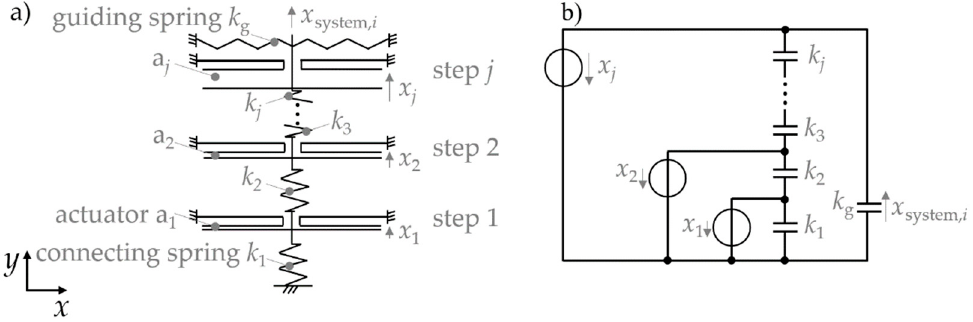
Figure 2. ( a ) Setup of the system, ( b ) analogous electrical network model, (drawings not to